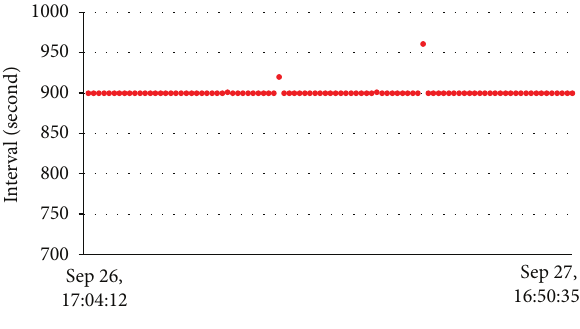
Figure 4: An access graph of HTTP malicious bot.